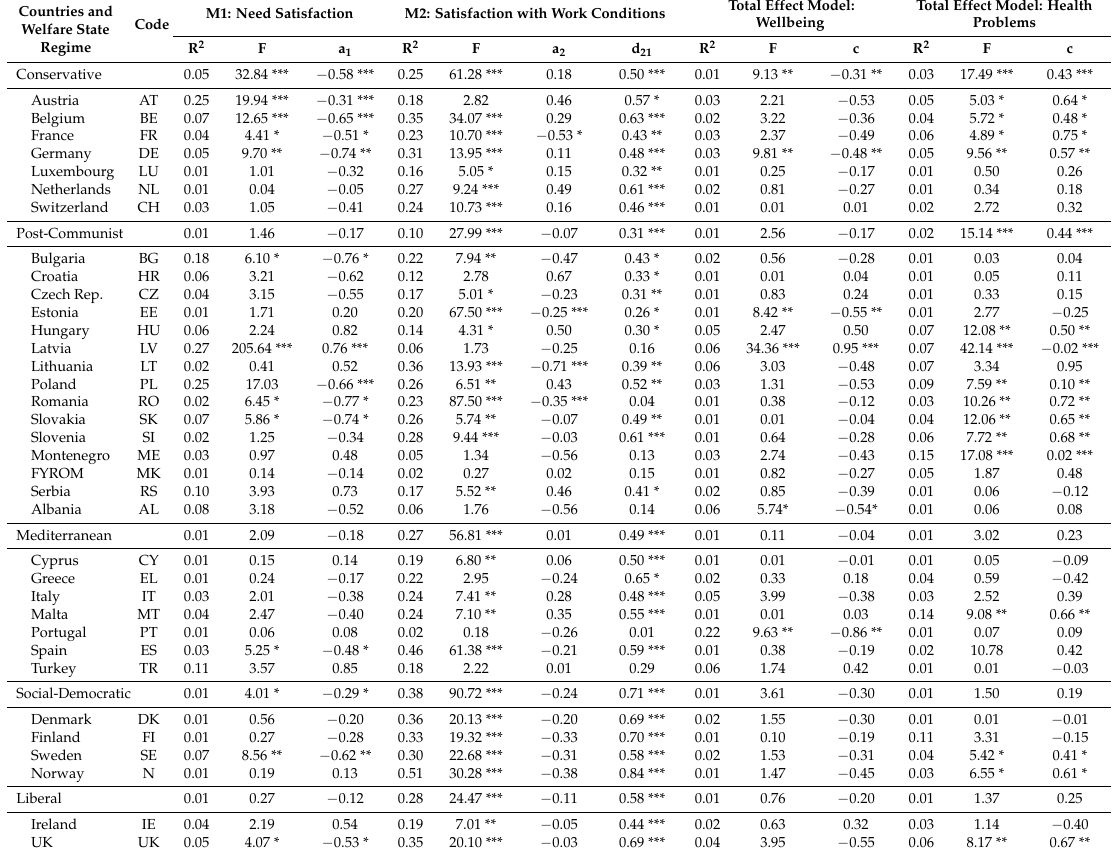
Table A2. Effects on mediators (i.e., needs satisfaction and satisfaction with work conditions) and total effects by gender on psychological well-being and health problems, by country and by welfare state regime. Countriesand WelfareState